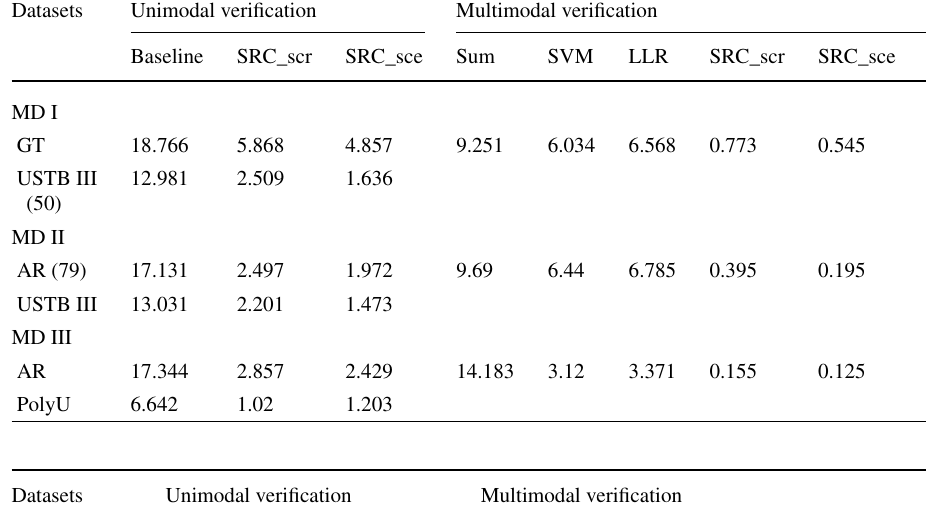
Table 4 Biometric verification performance (EER, %) when using CNN features